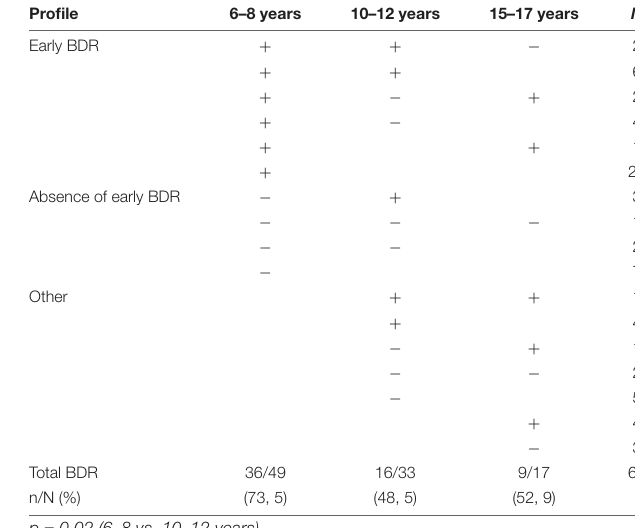
TABLE 5 | Prevalence of bronchodilatory responses